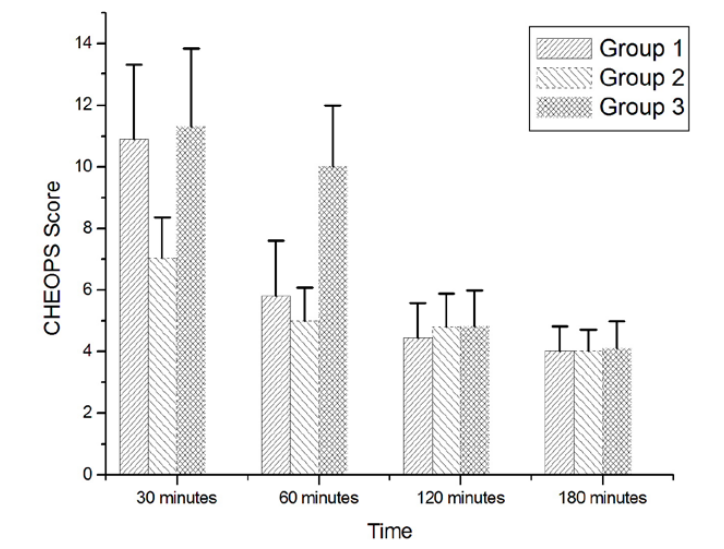
Figure 2 - ChEOPS Scores of the three groups at certain time